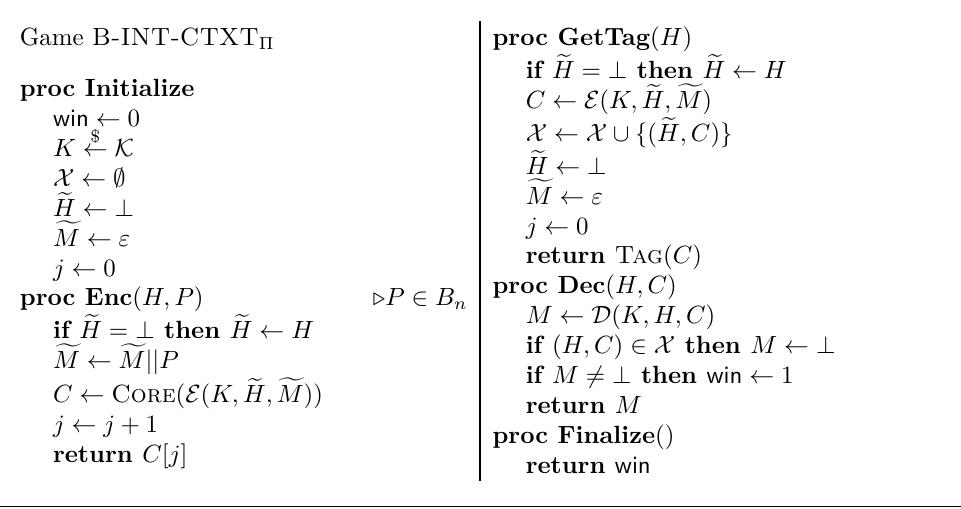
Figure 3: Game B-INT-CTXT Π used to define blockwise integrity of